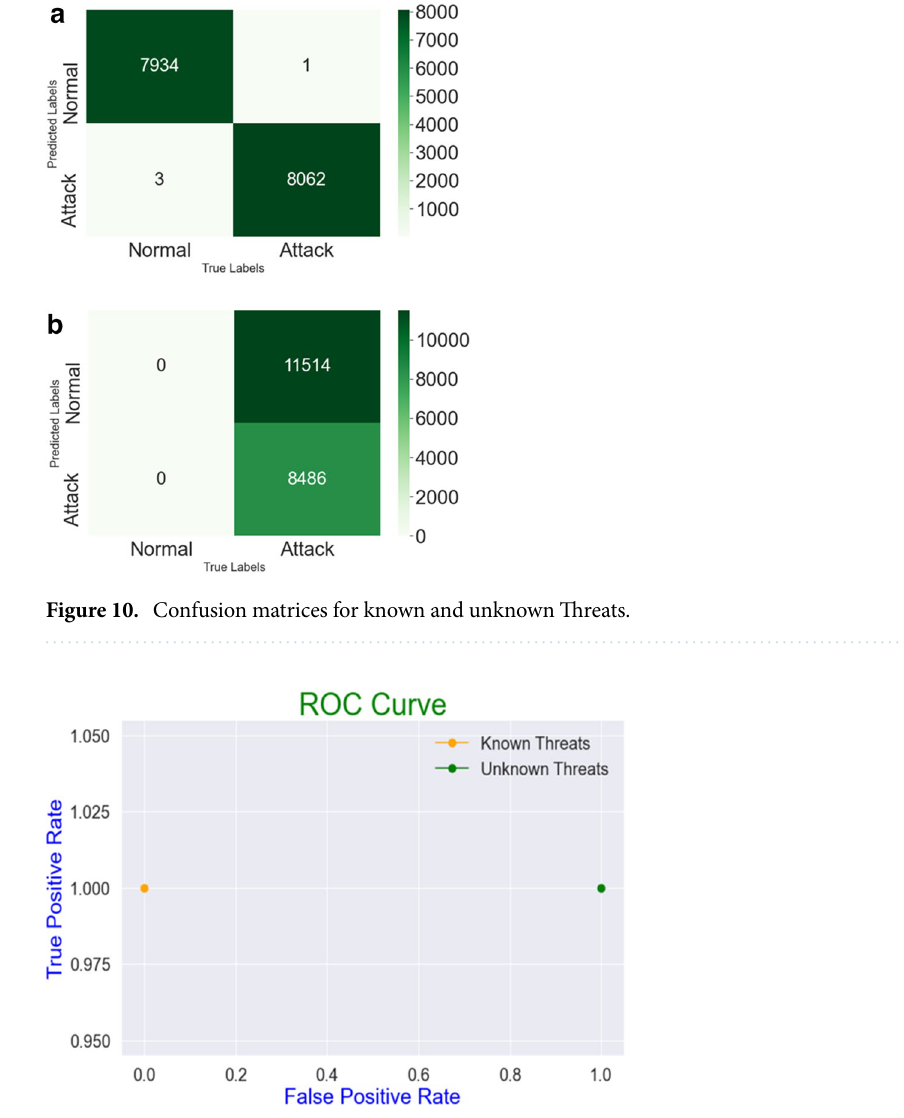
Figure 11. RoC Curve for known and unknown Threats.